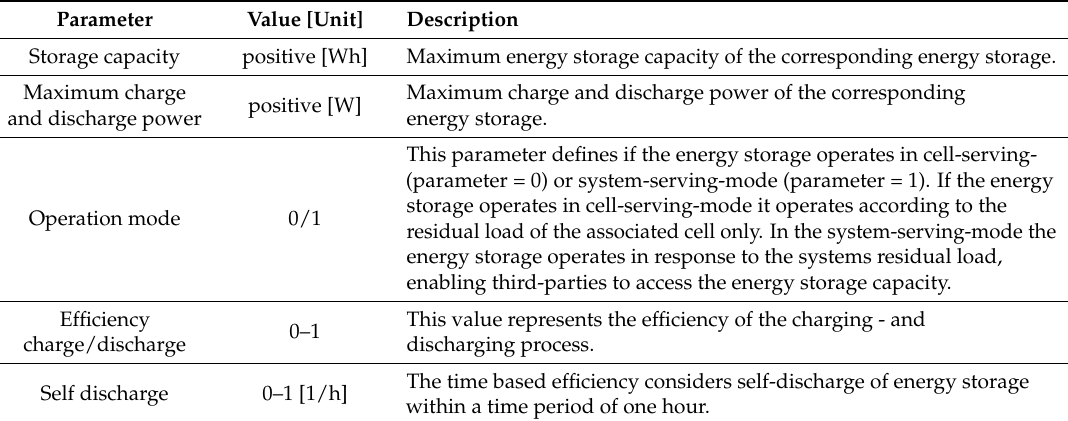
Table 1. Generic energy storage characterization in